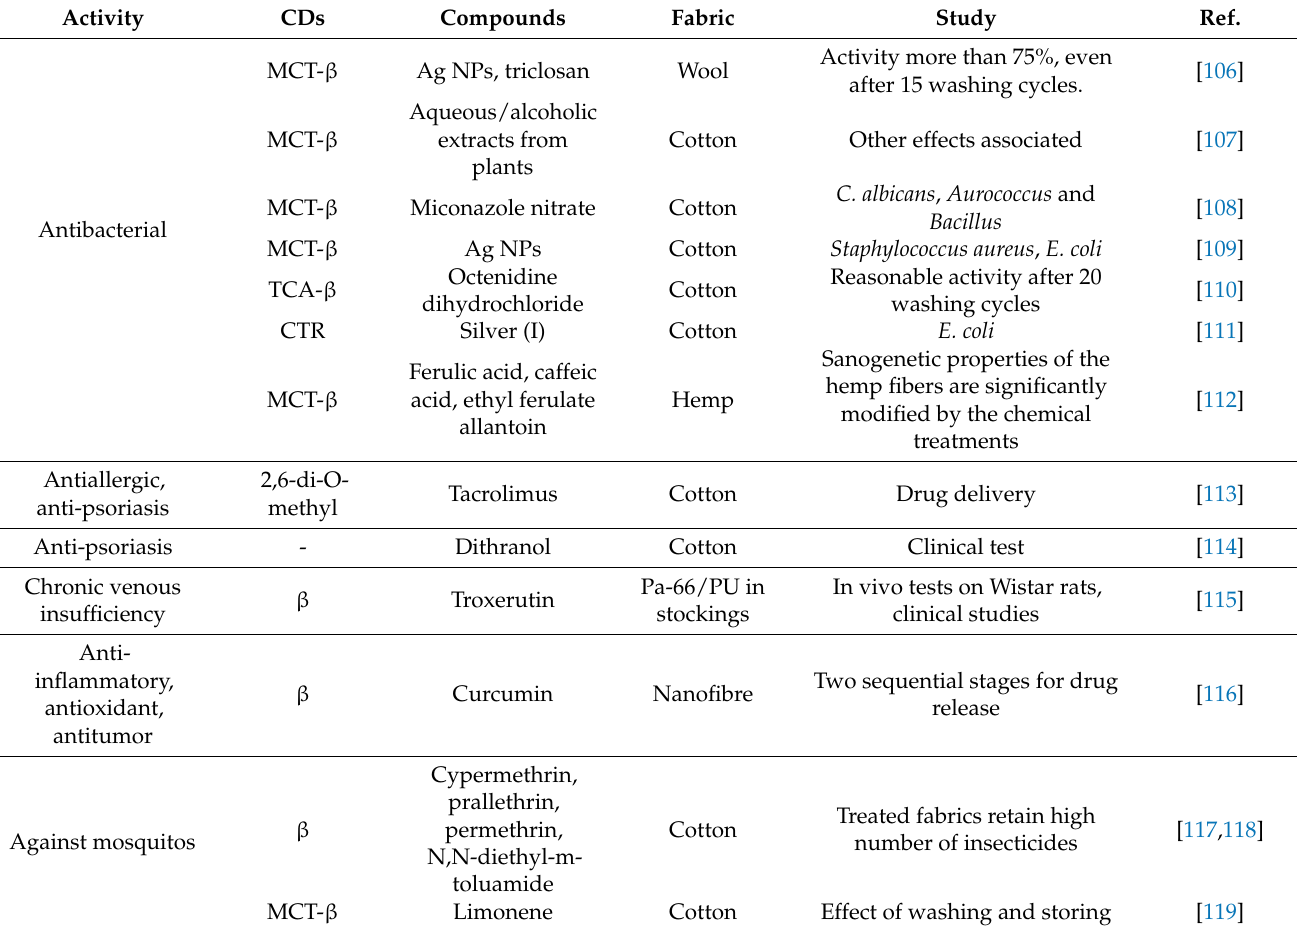
Table 6. Examples of studies using cyclodextrins (CDs) system on textile